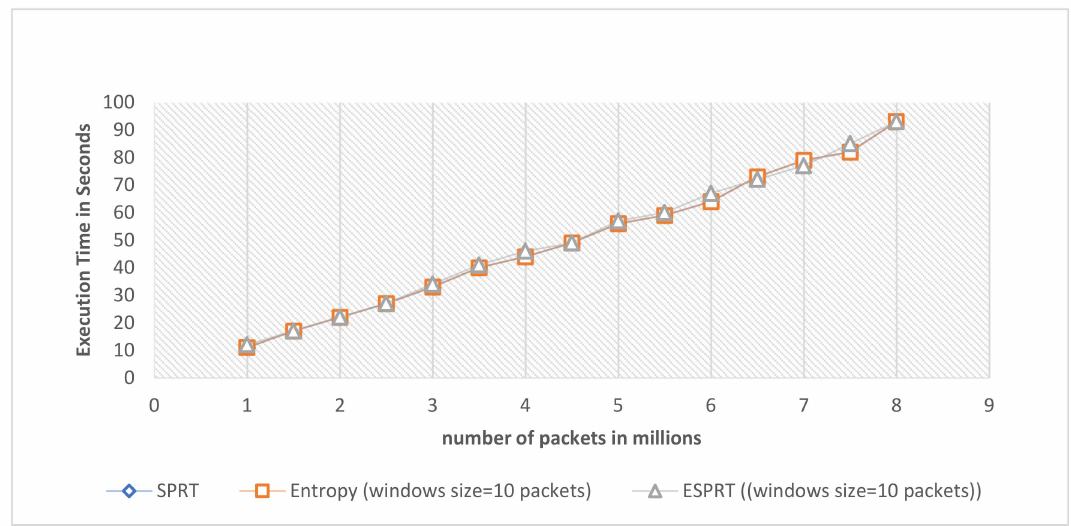
Figure 8. Execution time in seconds per specified number of packets for ESPRT, SPRT, and entropy